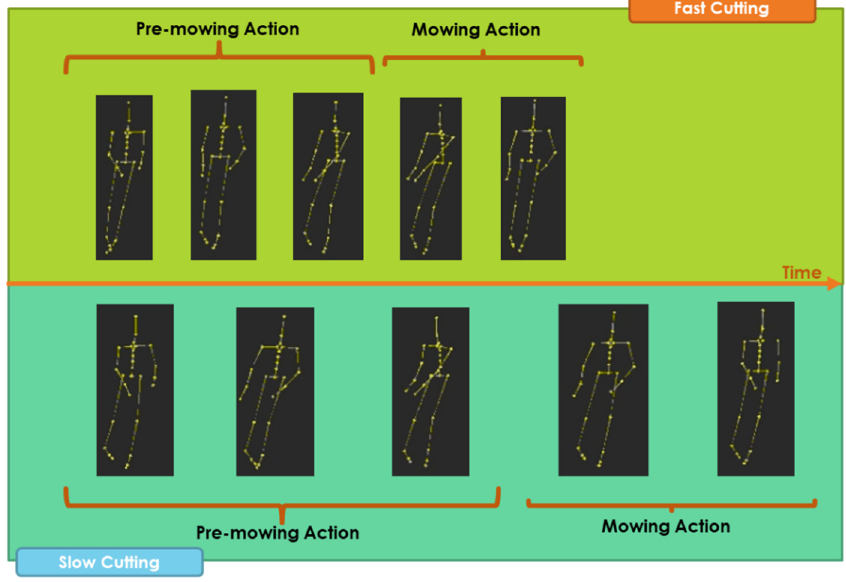
Figure 7. Two Different Types of Cutting Actions (Fast/Slow).